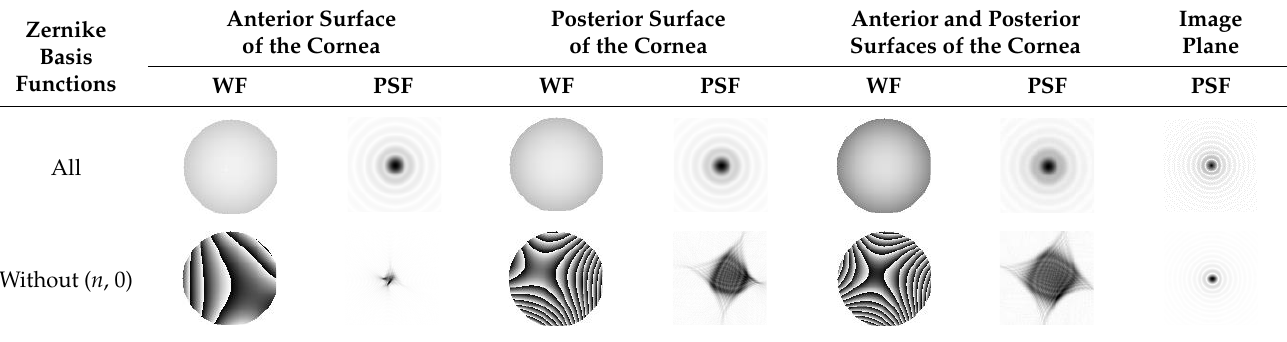
Table 1. Reconstructed wavefront (WF) and corresponding PSF for a cornea without pathology. Zernike